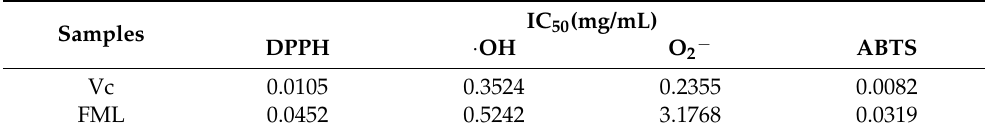
Table 2. IC 50 values of FML and Vc in antioxidant activity.